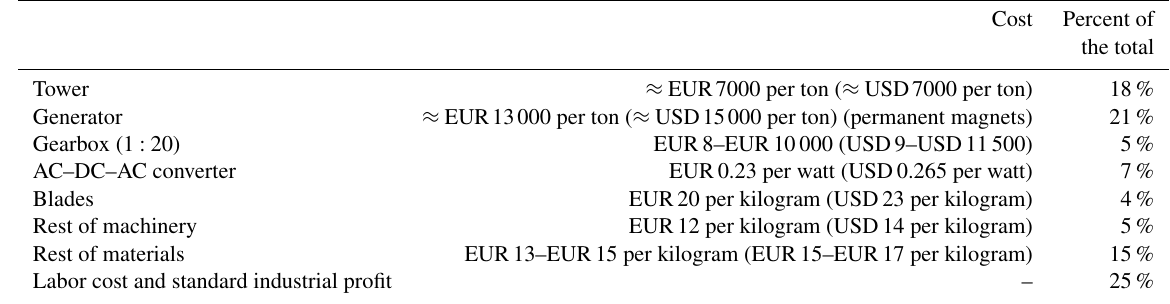
Table 2. Capital cost breakdown of a 60kW turbine (courtesy of the Eunice Energy Group). Weights reported in metric tons.